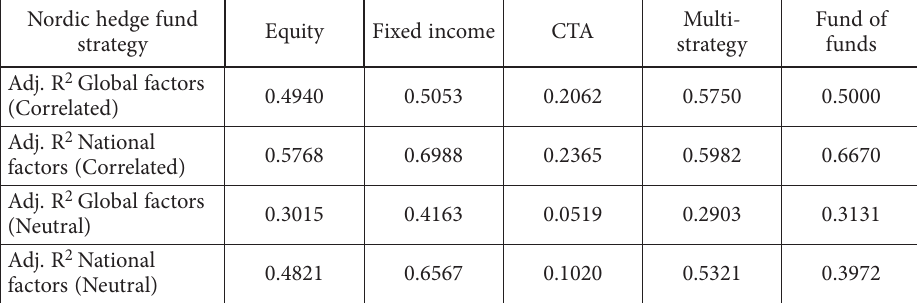
Multi- Fund of strategy